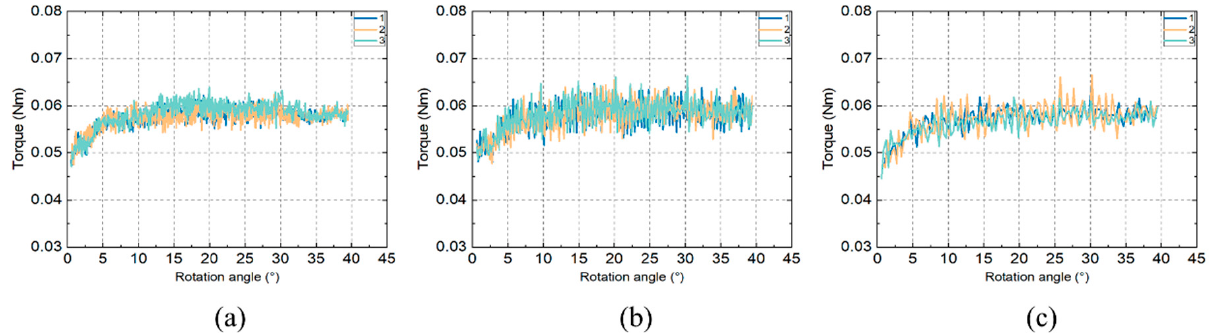
Figure 4. The relationship between the rotation angle and the measured torque for the speed at ( a ) 2 dps; ( b ) 5 dps and ( c ) 10 dps during the calibration experiment.